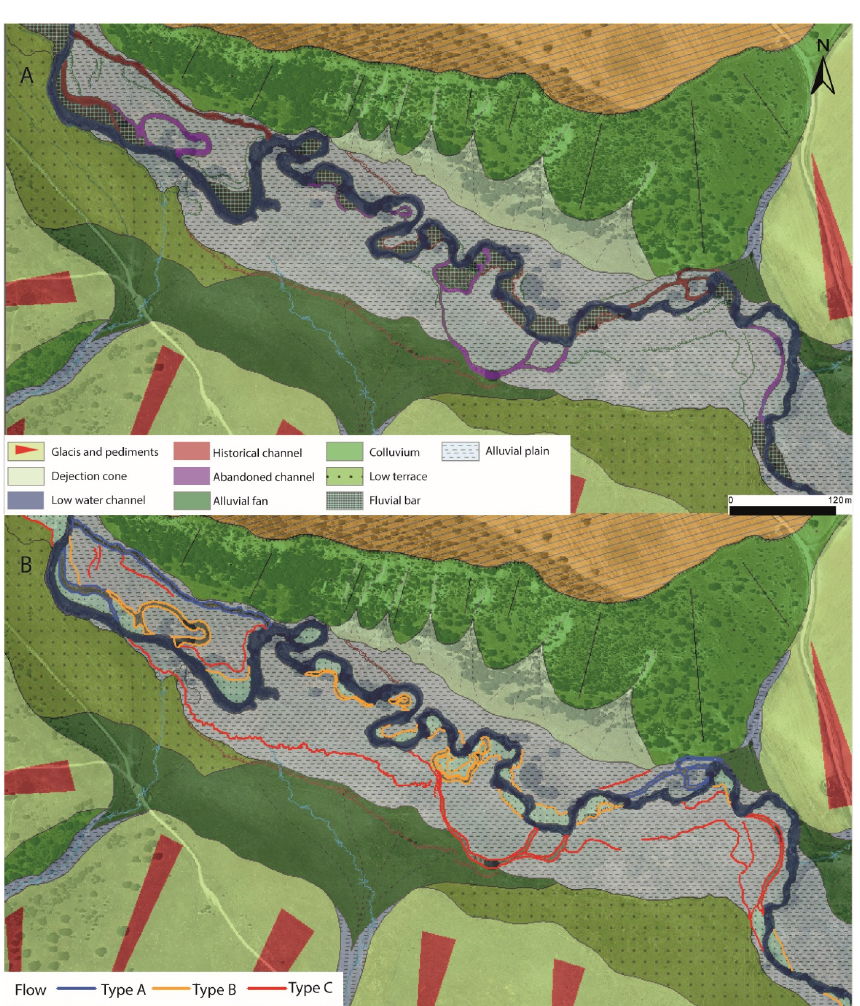
Figure 8. Stream classification scheme according to flow type: ( A ) Geomorphological mapping; ( B ) Categorized flows.